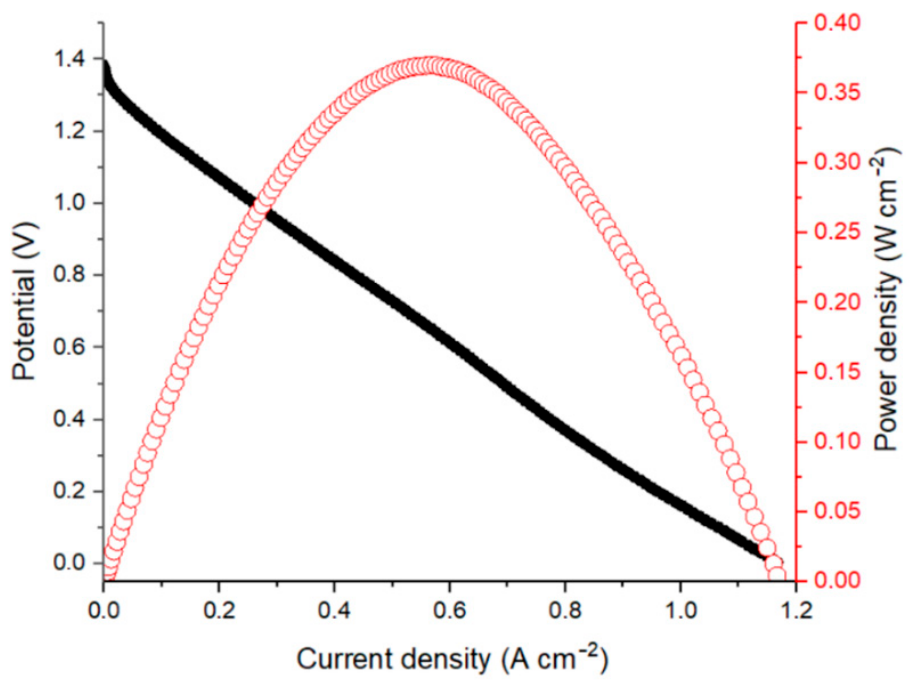
Figure 2. Polarization curve (black dots) and corresponding power density (red dots) for an AQBRFB measured at SOC: 100%, membrane: GP-IEM-103, temperature: 25 ◦ C, flow: through flow field, flow rate: 100 mL min − 1 . Posolyte composition: 1 M LiBrO 3 in 6 M H 2 SO 4 , negolyte composition: 0.8 M AQDSH 2 in 1 M H 2 SO 4 .